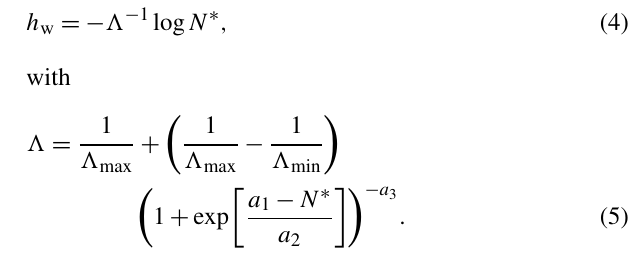
Figure 1. Photograph of Hydroinnova SnowFox ™ cosmic ray neu- tron sensor (CRNS) exposed in firn trench on the first day of deploy- ment. Inset shows the location of Summit Camp on the Greenland Ice Sheet, as denoted by the red circle. The red triangle shows the location of the THUL reference neutron monitor maintained by the University of Delaware Bartol